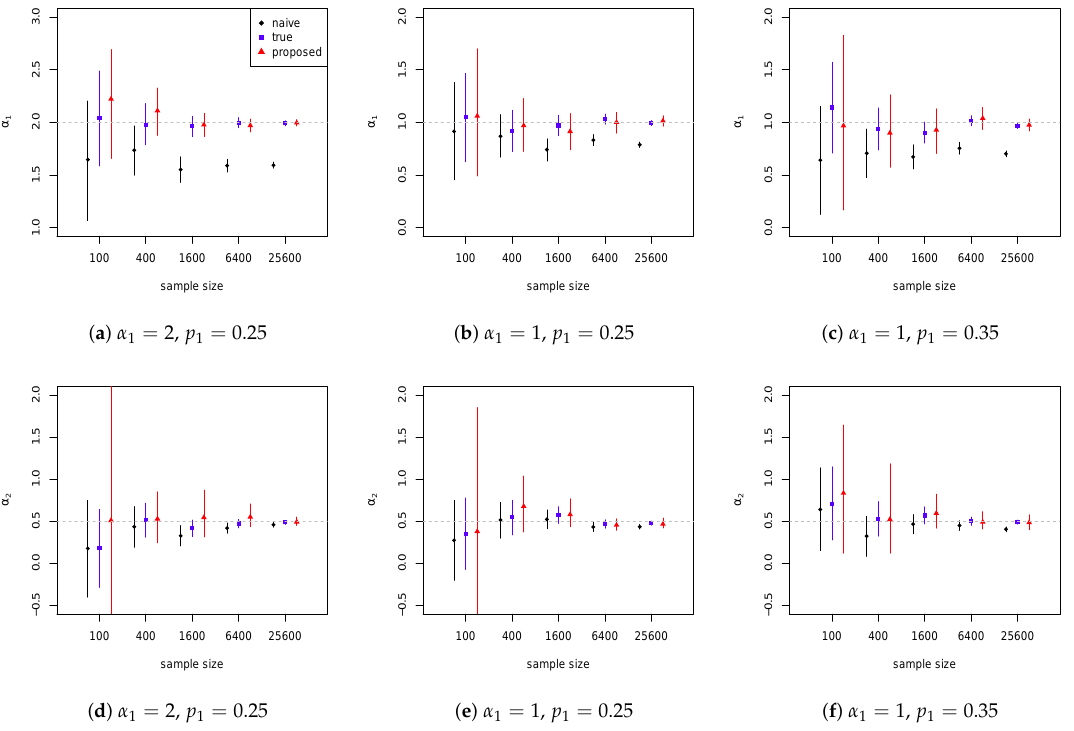
Figure 3. Credible intervals for the risk effects of V 1 (top) and V 2 (bottom) for the lognormal loss severity model. The dashed line marks the true